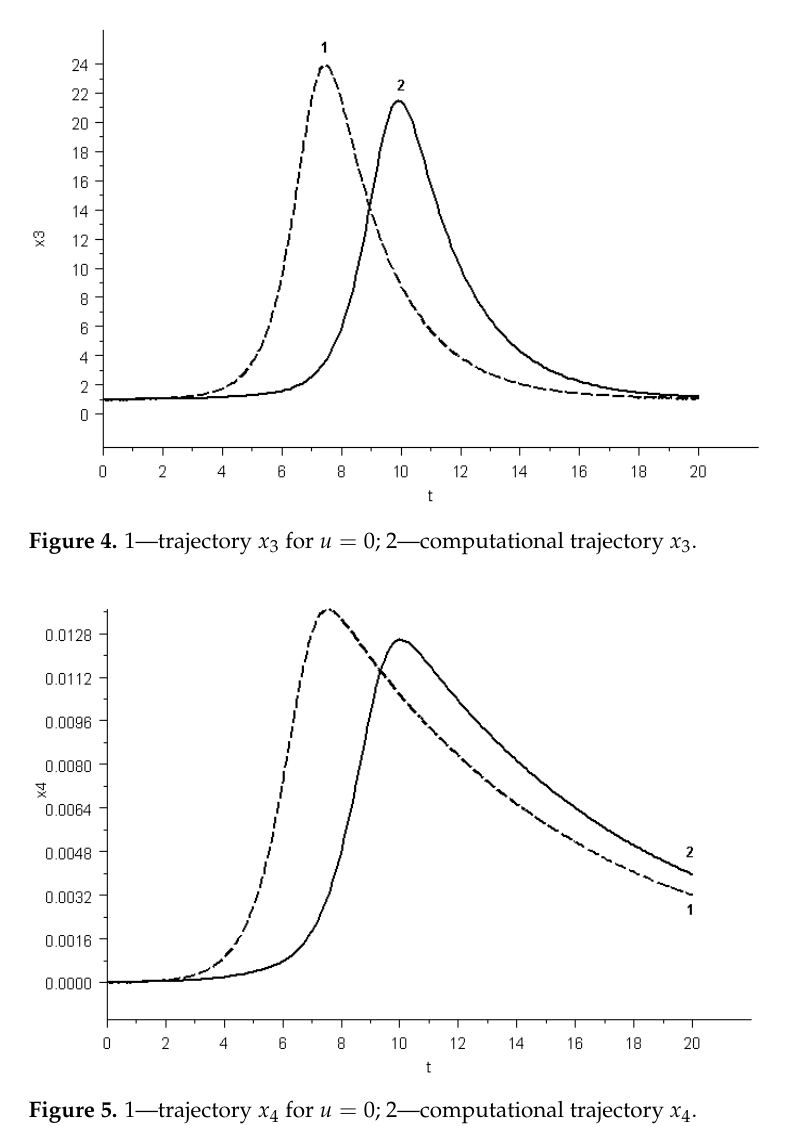
Figure 3. 1—trajectory x 2 for u = 0; 2—computational trajectory x 2 .